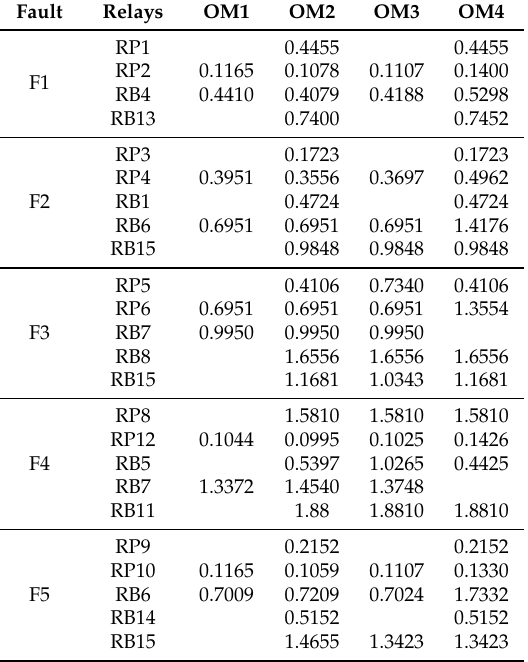
Table 12. Operation times for all OMs with a single set of